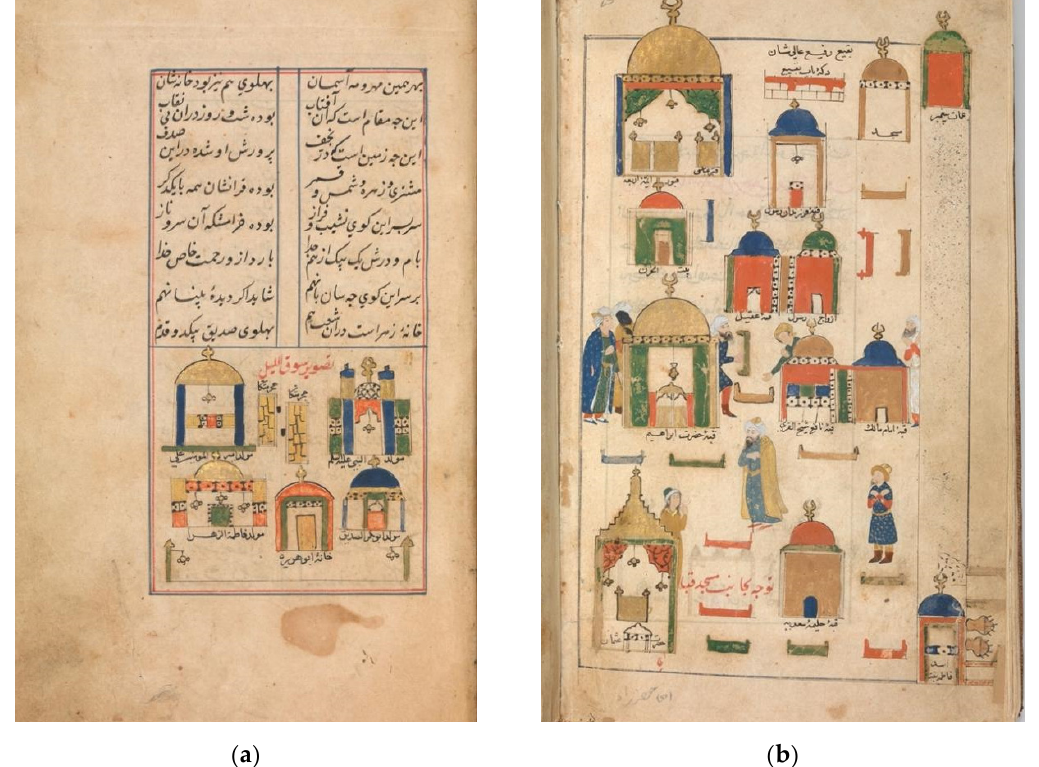
Figure 3. ( a ) Illustration of Fut¯uh. al-H. aramayn , The Metropolitan Museum of Art, 32.131, 22r. photo in public domain. ( b ) Illustration of Fut¯uh. al-H. aramayn , The Metropolitan Museum of Art, 32.131, 24r. photo in public